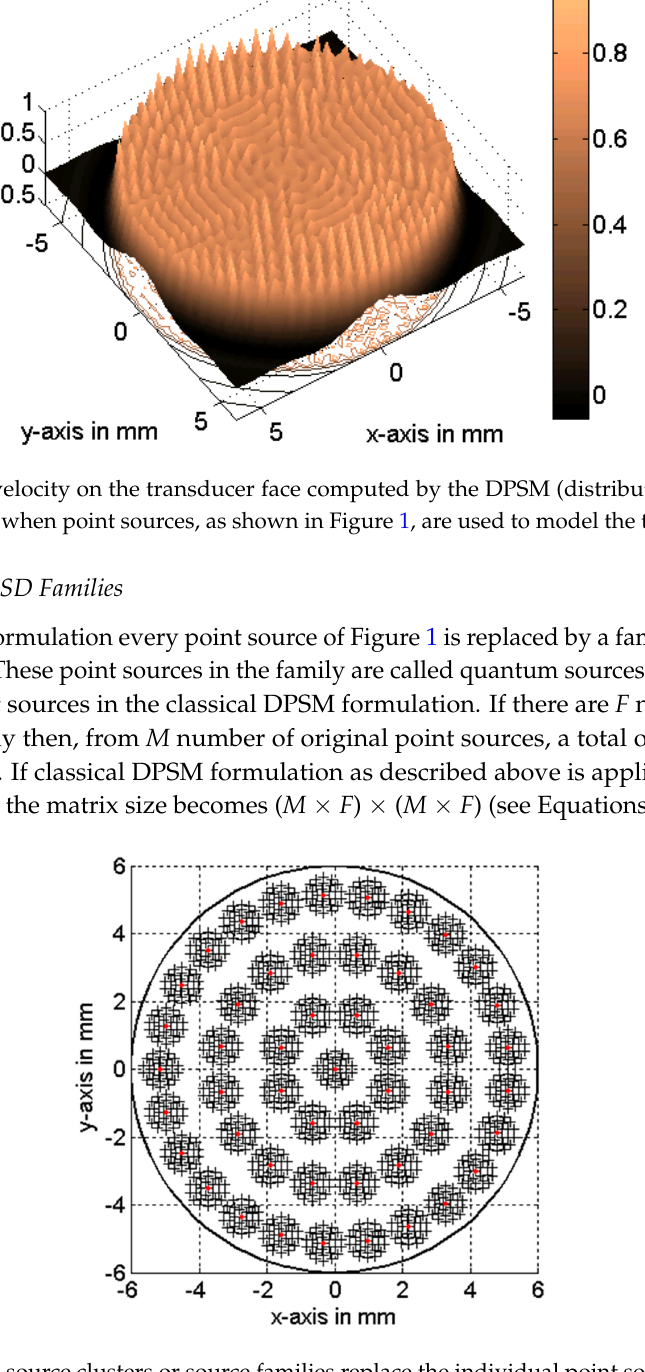
Figure 3. Quantum source clusters or source families replace the individual point sources in the new formulation for modeling the transducer.